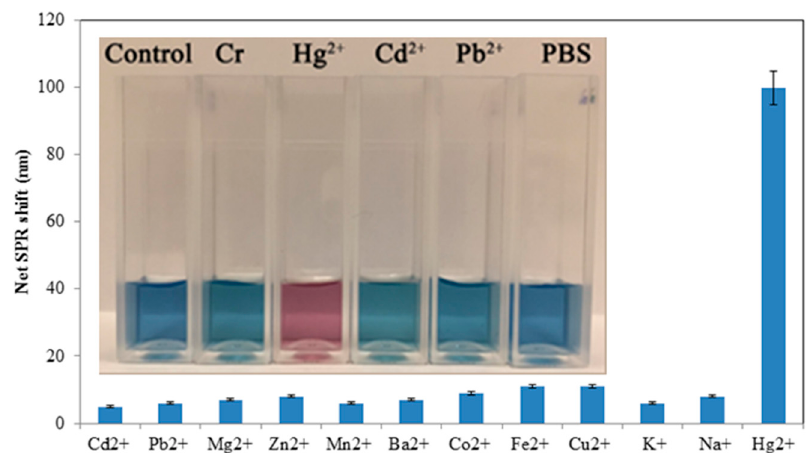
Figure 9. E ff ect of various metal ions (5 µ M) dissolved in 5 mM phosphate bu ff ered saline pH 7.2 on the net SPR shift, showing high reactivity with only Hg 2 + . Inset: photograph of AgNP solutions, showing Figure 9. Effect of various metal ions (5 µM) dissolved in 5 mM phosphate buffered saline pH 7.2 on color change with Hg 2 + and lack of significant response to phosphate-bu ff ered saline (PBS), deionized the net SPR shift, showing high reactivity with only Hg 2+ . Inset: photograph of AgNP solutions, water (Control), and the other ions Cd 2 + , Pb 2 + and CrO 42- (labelled “Cr”) at 10 µ showing color change with Hg 2+ and lack of significant response to phosphate-buffered saline (PBS), deionized water (Control), and the other ions Cd 2+ , Pb 2+ and CrO 42- (labelled “Cr”) at 10 µM.